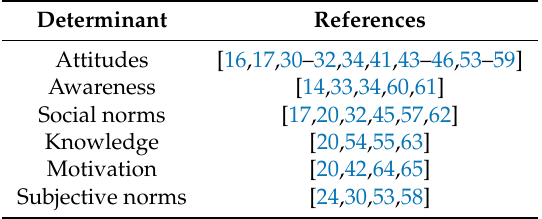
Table 4. Psychological and social determinants in public